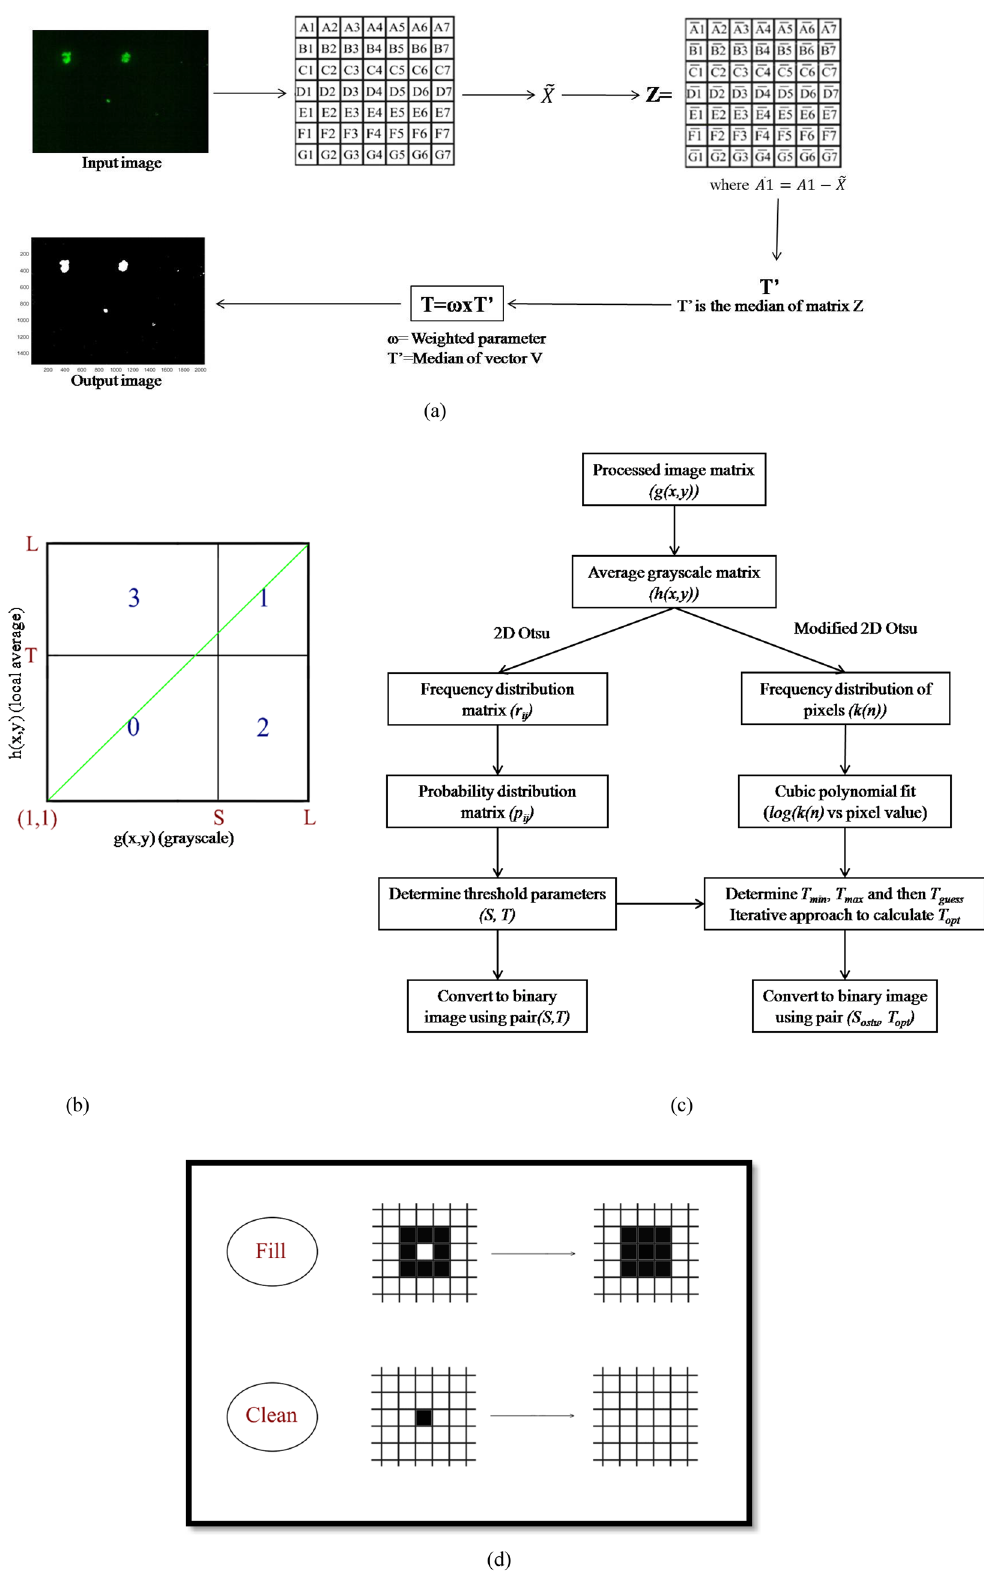
Figure 3. Various steps of median thresholding are shown in ( a ). Further, ( b ) represents the separated classes by the threshold ( S,T) , ( c ) is the different stages of 2D Otsu and modified 2D Otsu thresholding and ( d ) shows the ‘Fill’ and ‘Clean’ morphological